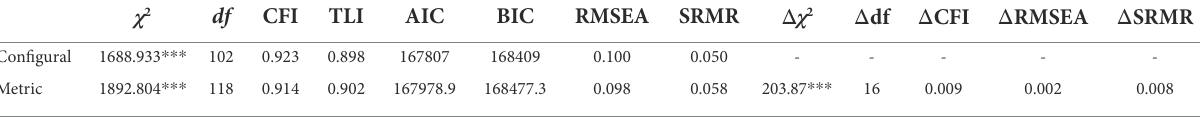
TABLE 3 Fit of measurement invariance (configural and metric) of two factor model. χ